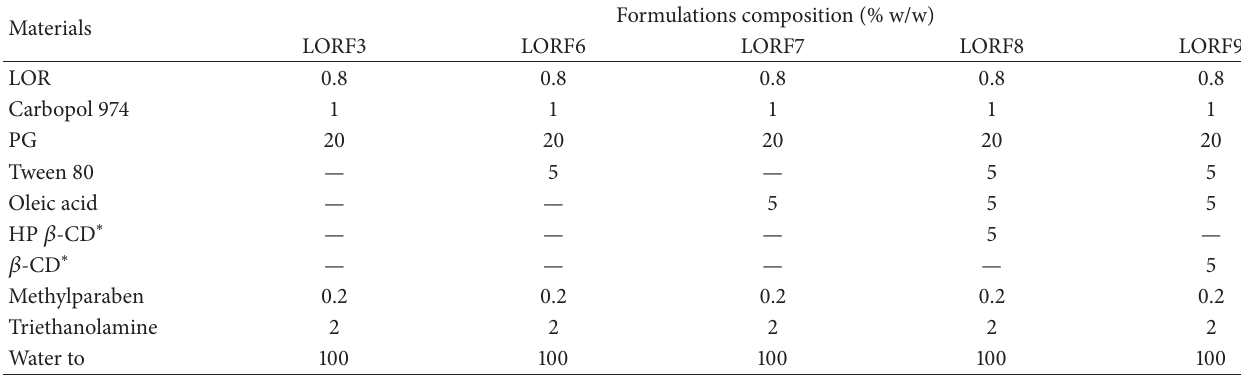
Table 2: Composition of carbopol gel formulations containing different enhancers.